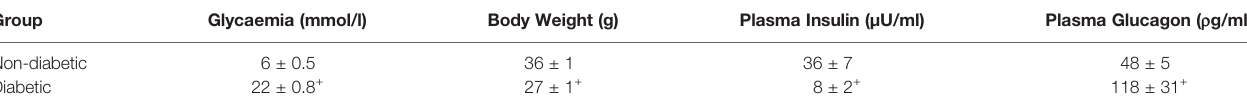
Diabetes was induced by a single intravenous injection of alloxan (65 mg/kg), and the analyses performed 21 days after diabetes induction. Values represent the mean ± S.E.M. of 8 animals. + P < 0.05 compared to non-diabetic